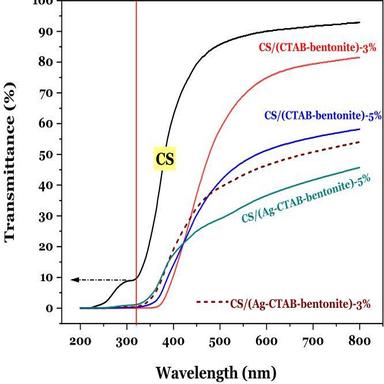
Optical property of the resultant films (their UV–vis light transmittance vs. wavelength).